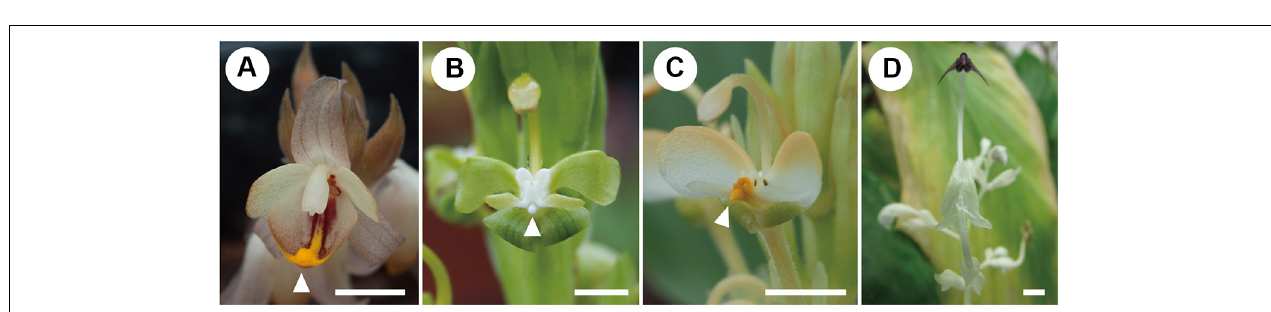
FIGURE 2 | Mature flowers of investigated species. (A) Hemiorchis burmanica. (B) Gagnepainia harmandii. (C) Gagnepainia godefroyi. (D) Globba geofrayii. White arrows indicate the position of central carina with apical projection. Scale bars = 5 mm.